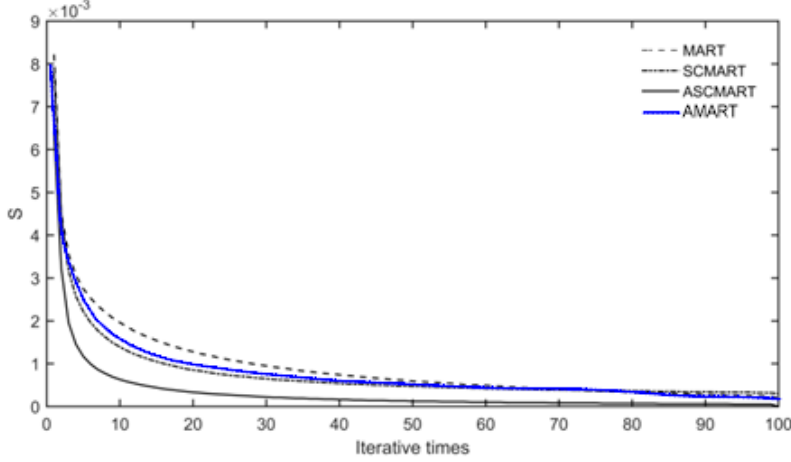
Figure 5. Comparison of the convergence speed of ASMART, SCMART, AMART, and MART.